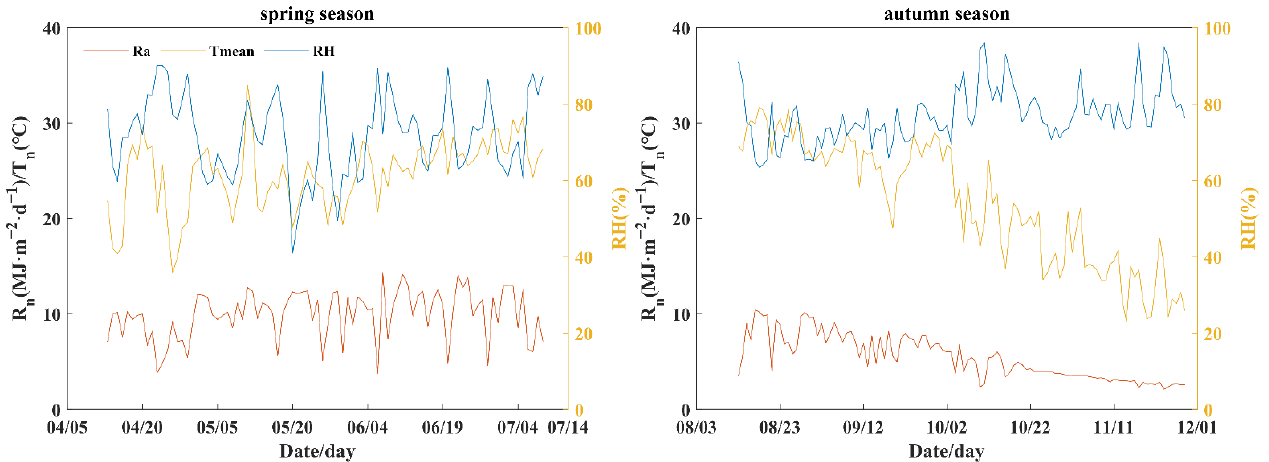
Figure 1. The basic meteorological information during the growth stages.